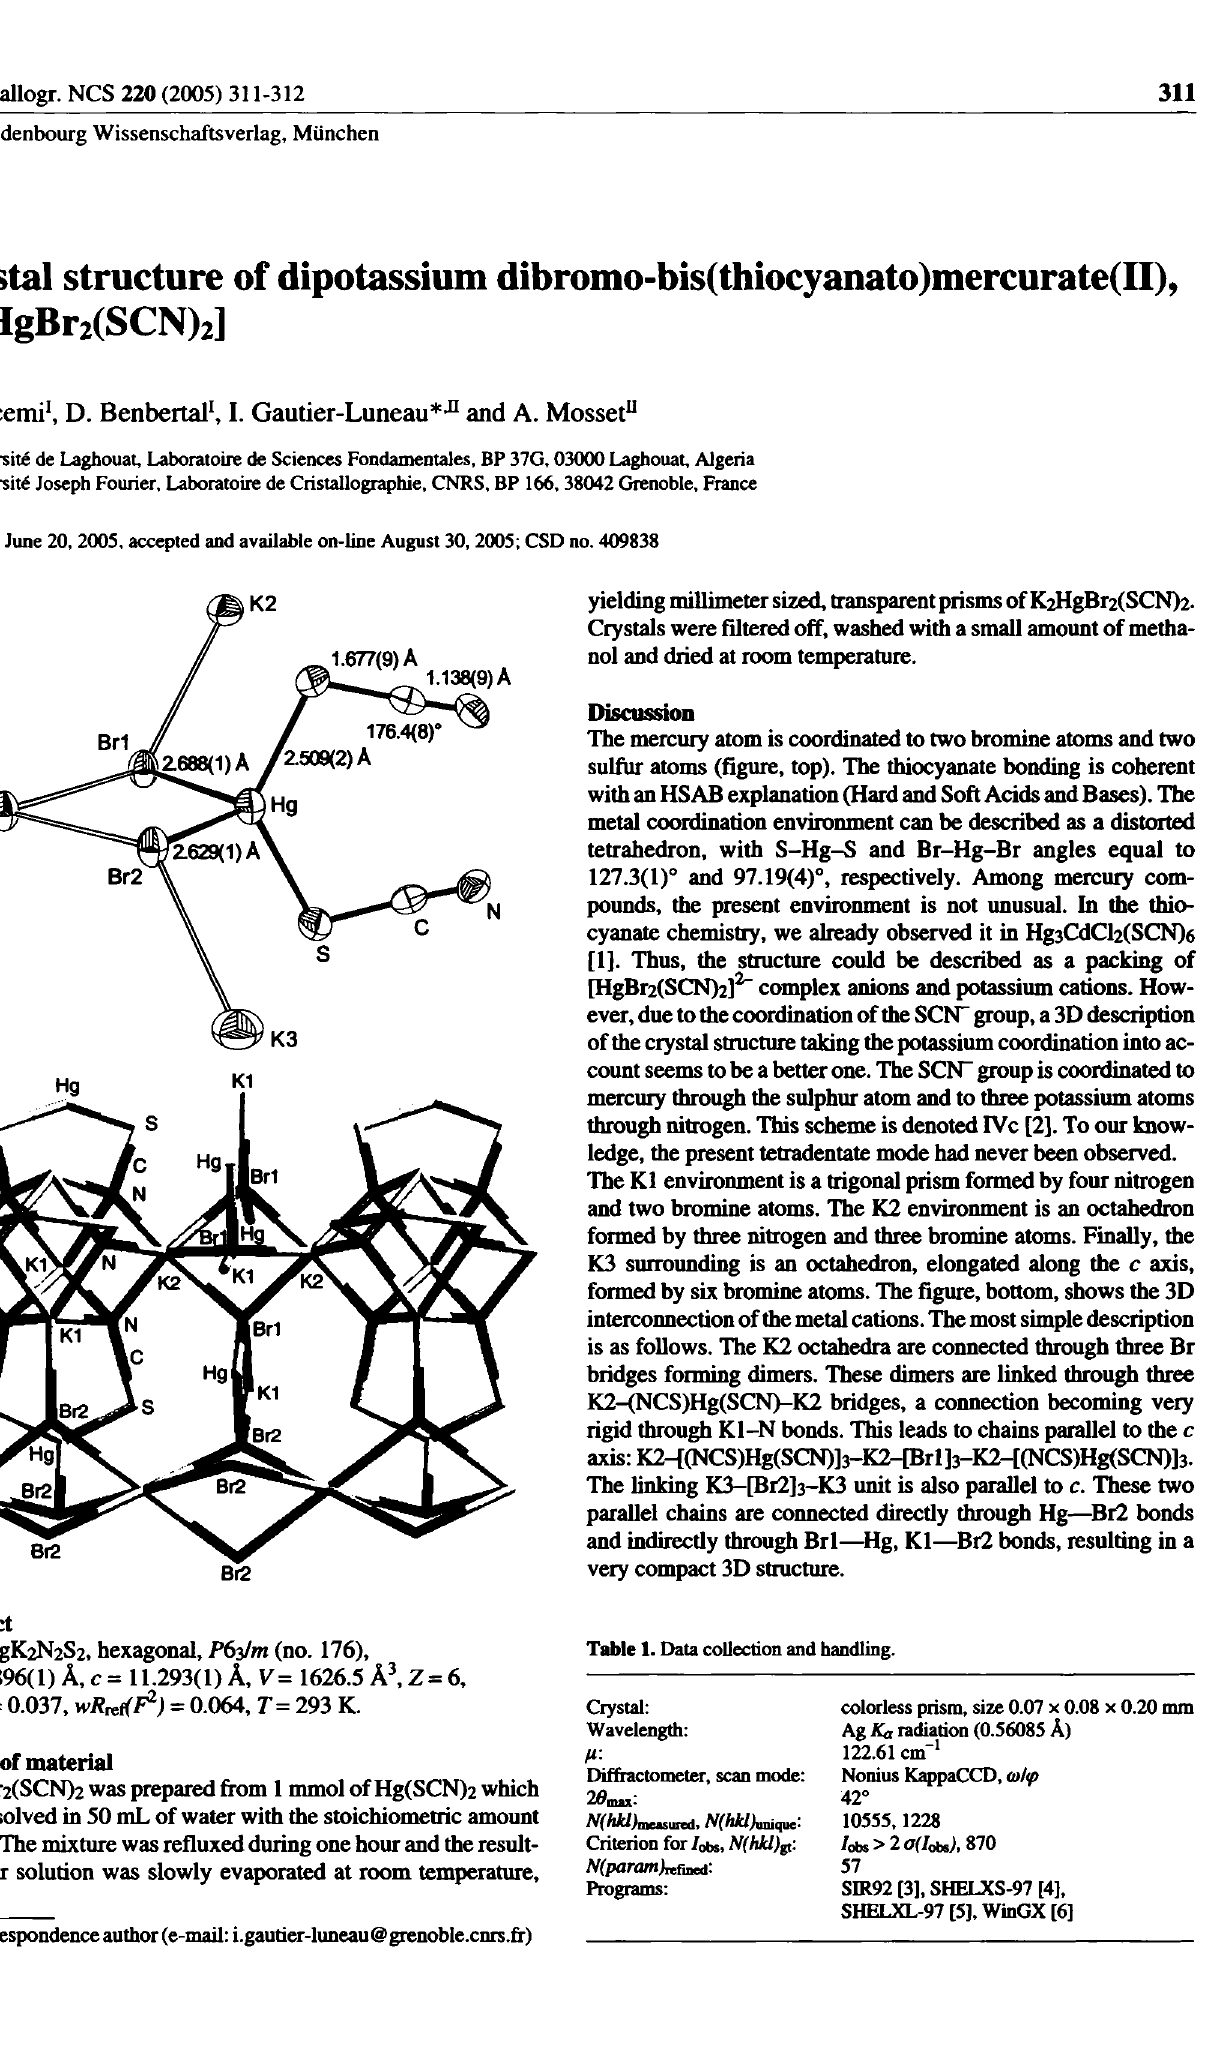
Table 1. Data collection and